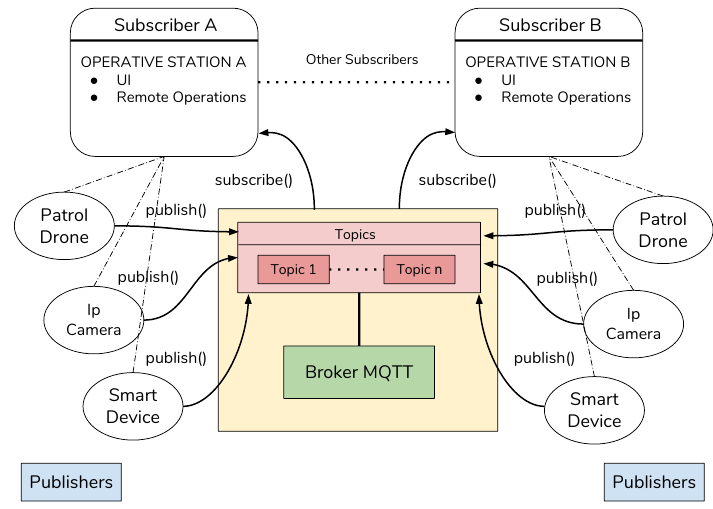
Figure 7. Machine-to-machine (M2M)-based communication